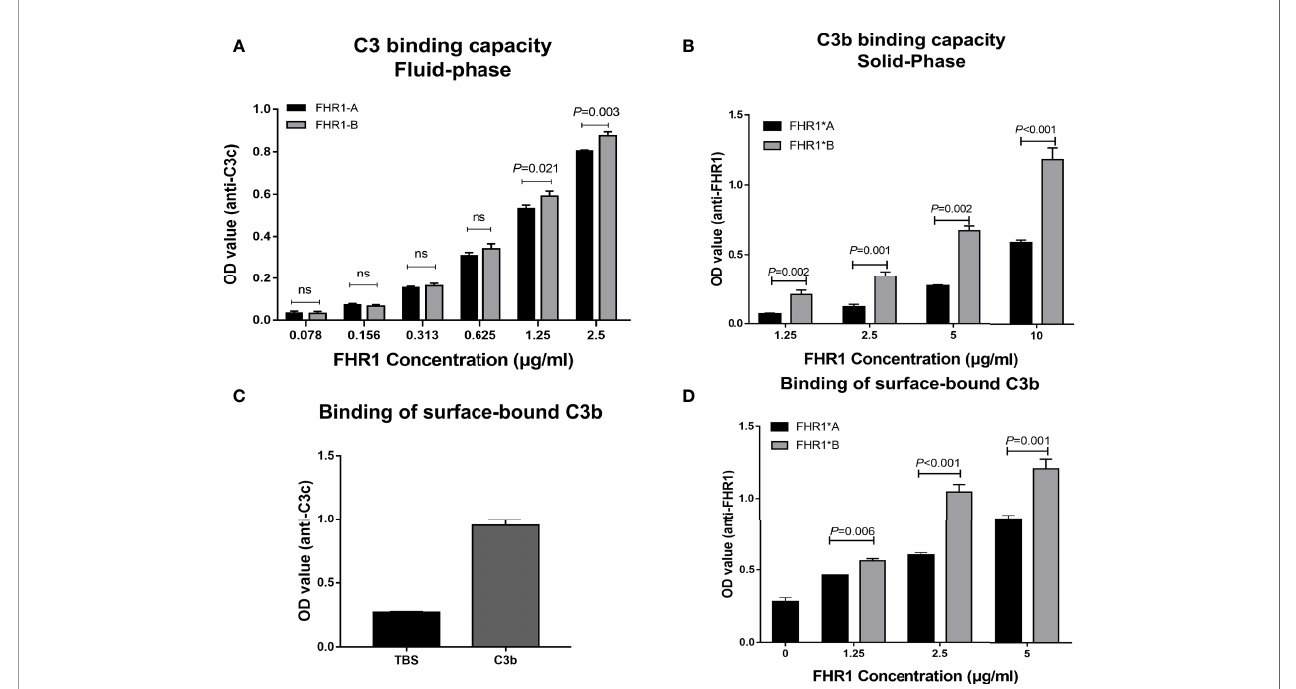
FIGURE 2 | Interaction of the two FHR1 isoforms with C3b. Equal concentrations of two immobilized isoforms of FHR1 (0.078 m g/ml-2.5 m g/ml) bound C3b (2 m g/ ml) in a dose-dependent manner. The binding-C3b was fi nally detected. FHR1*B showed a higher capacity to bind C3b at a concentration of 1.25 m g/ml (A) . In a reverse setting, equal concentrations of two isoforms of FHR1 (1.25 m g/ml-10 m g/ml) bound immobilized C3b (100nM) in a dose-dependent manner. The bound FHR1 was detected at last. FHR1*B also showed higher binding capacity to C3b (B) . Moreover, the 100nM C3b were added onto the microplates, overspread with the Saccharomyces cerevisiae , and equal concentrations of two isoforms of FHR1 (1.25 m g/ml-5 m g/ml) was added. The surface-bound C3b was detected by anti- C3c antibody (C) , and the binding of FHR1 to surface-bound C3b was detected with anti-FHR1 antibody (D) . The representative fi gures from three independent experiments are shown. The results are representative of three independent experiments. The data are presented as the means ± SDs. The symbol ns indicates nonsigni fi